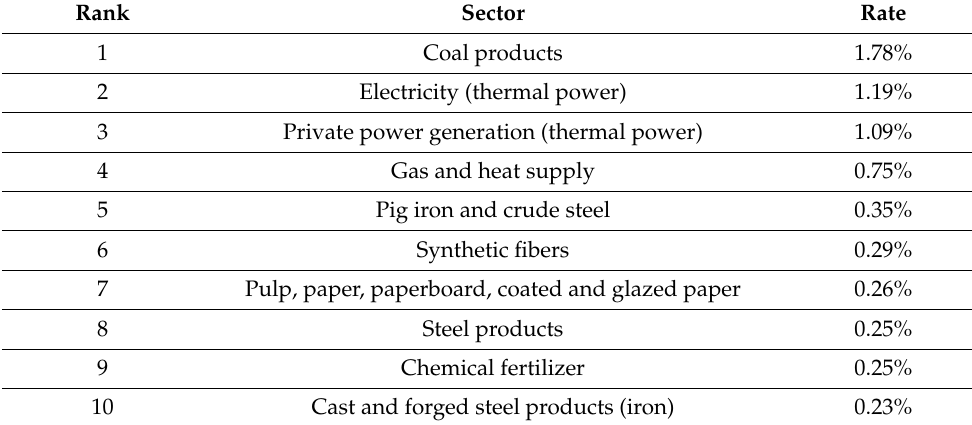
Table 5. Price increase due to a change in the main tax rate for coal and gas (top 10 sectors, unit: %). Rank Sector Rate 1 Coal products 1.78% 2 Electricity (thermal power) 1.19% 3 Private power generation (thermal power) 1.09% 4 Gas and heat supply 0.75% 5 Pig iron and crude steel 0.35% 6 Synthetic fibers 0.29% 7 Pulp, paper, paperboard, coated and glazed paper 0.26% 8 Steel products 0.25% 9 Chemical fertilizer 0.25% 10 Cast and forged steel products (iron)